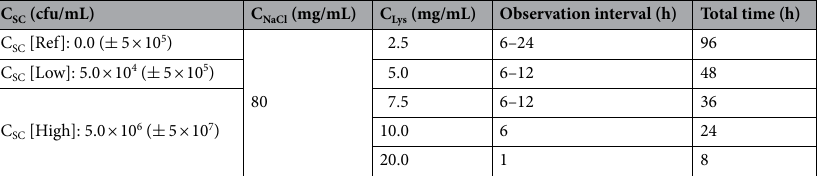
Table 2. Experimental conditions of the crystallisation with and without biotemplates. C SC concentration of S. cerevisiae, C NaCl concentration of sodium chloride, C Lys concentration of